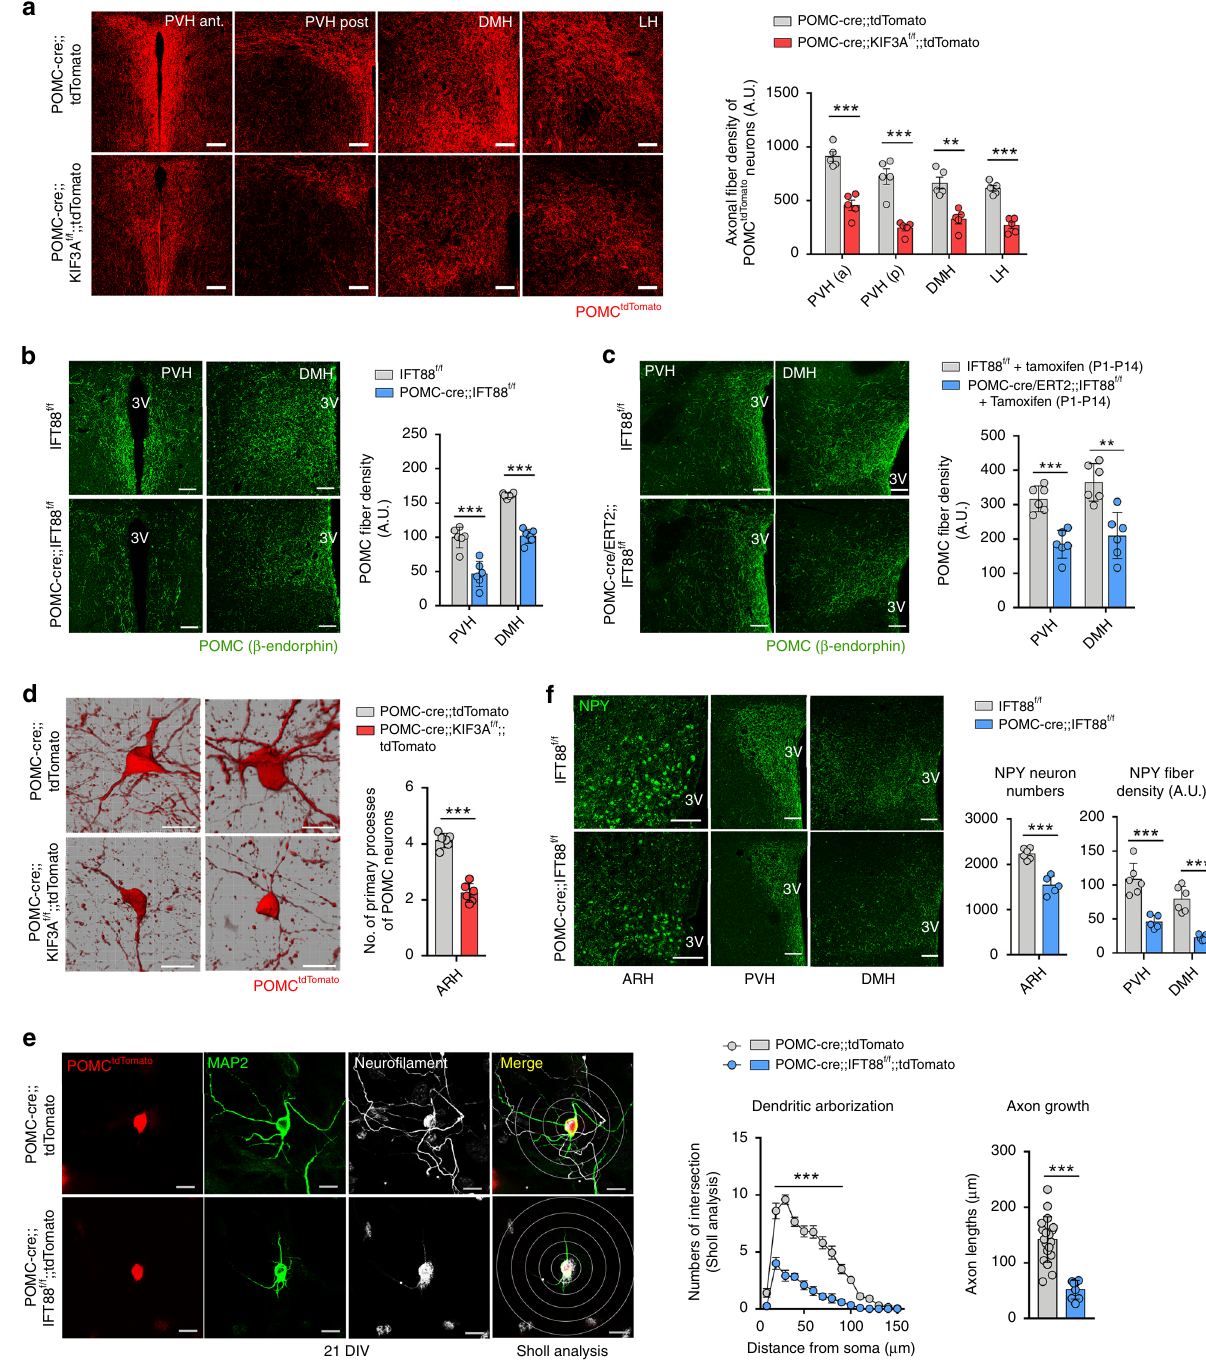
and 21 days in vitro culture (Fig. 5e and Supplementary Fig. 3), suggesting impaired axon and dendrite outgrowth in POMC neurons with disrupted ciliogenesis. A certain proportion of ARH NPY/AGRP neurons originate from the POMC-expressing neuronal precursors 10 . Indeed, NPY immunostaining revealed a signi fi cant decrease in the NPY neuron number and axonal fi ber density in POMC-cre;;IFT88 f/f mice at 3 weeks (Fig. 5f). All these evidence indicated that ciliary defects disrupt normal circuit formation in the neurons derived from embryonic POMC- expressing neural